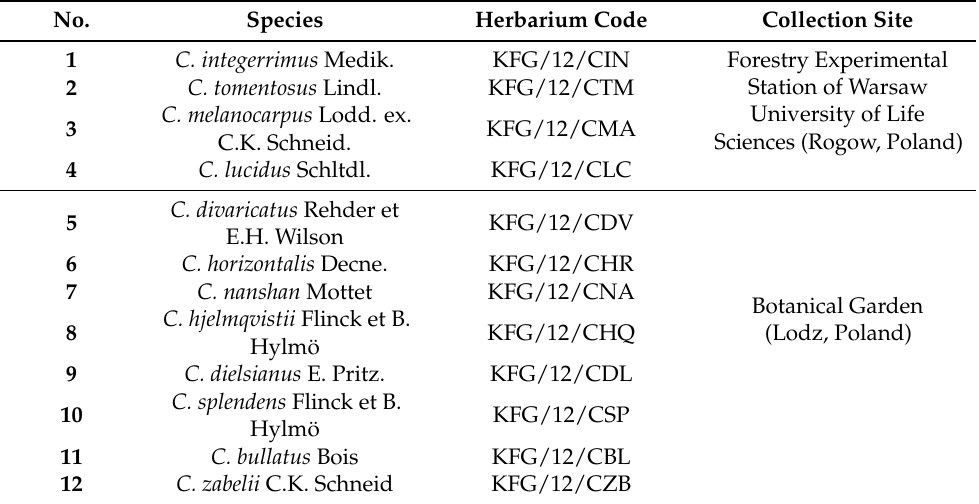
Table 5. Herbarium codes and collection sites of the analyzed Cotoneaster Medik.